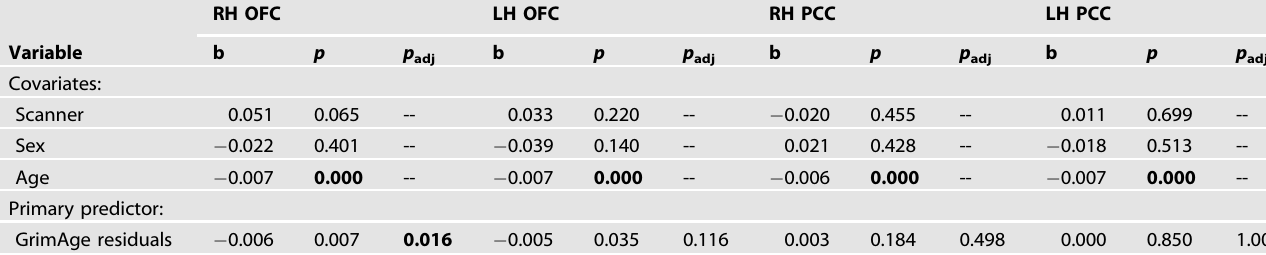
Table 5. Associations between GrimAge residuals and cortical thickness in regions of interest.